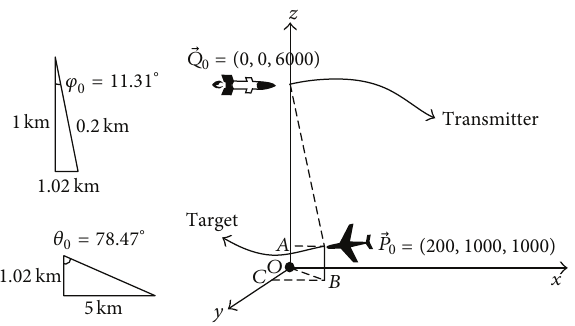
Figure 11: The trajectory diagram in the case of nonlinear